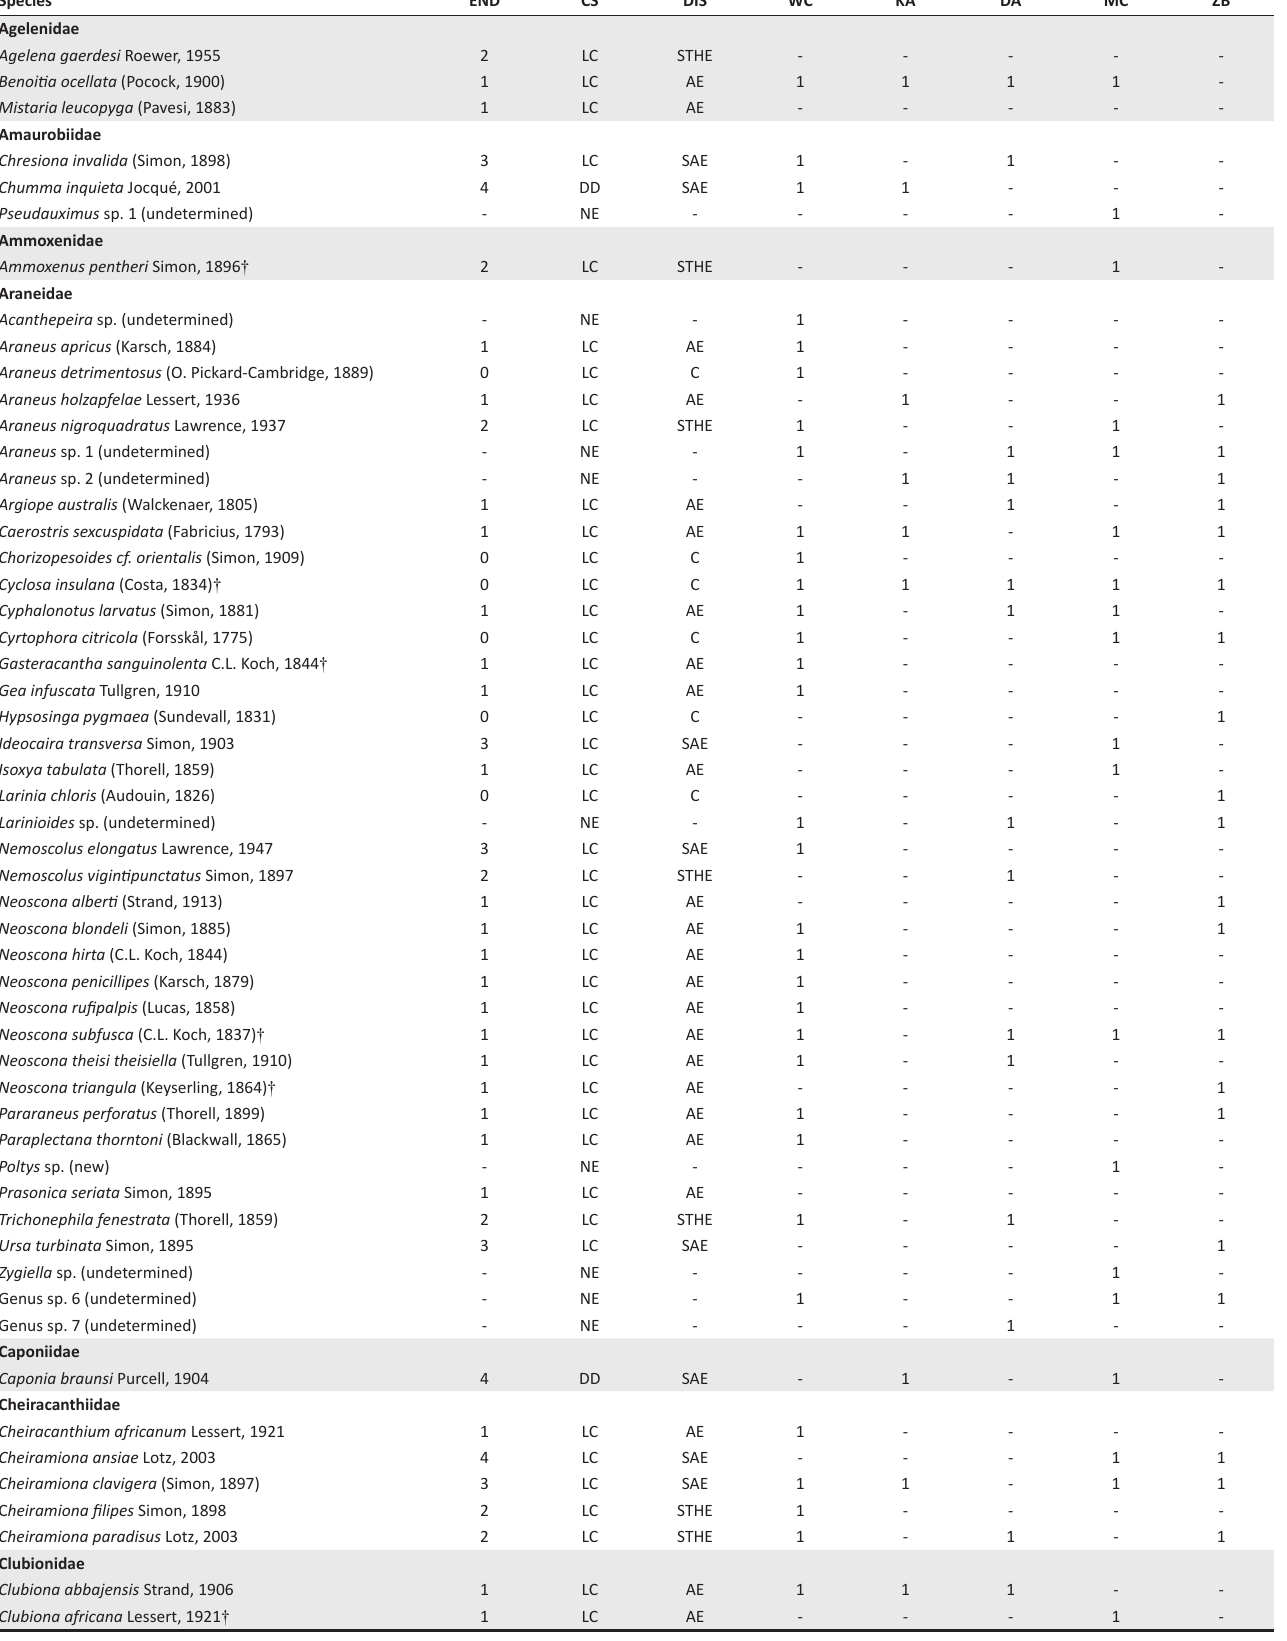
TABLE 1-A1: Spiders of the Addo Elephant National Park, listing their endemicity, conservation status, distribution and areas sampled in the park.